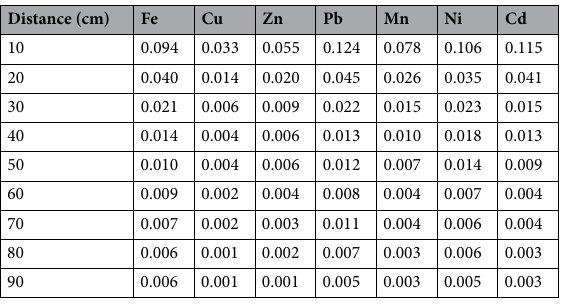
Table 4. Estimated concentration of the contaminants from leachate flux (mol L −1 ).